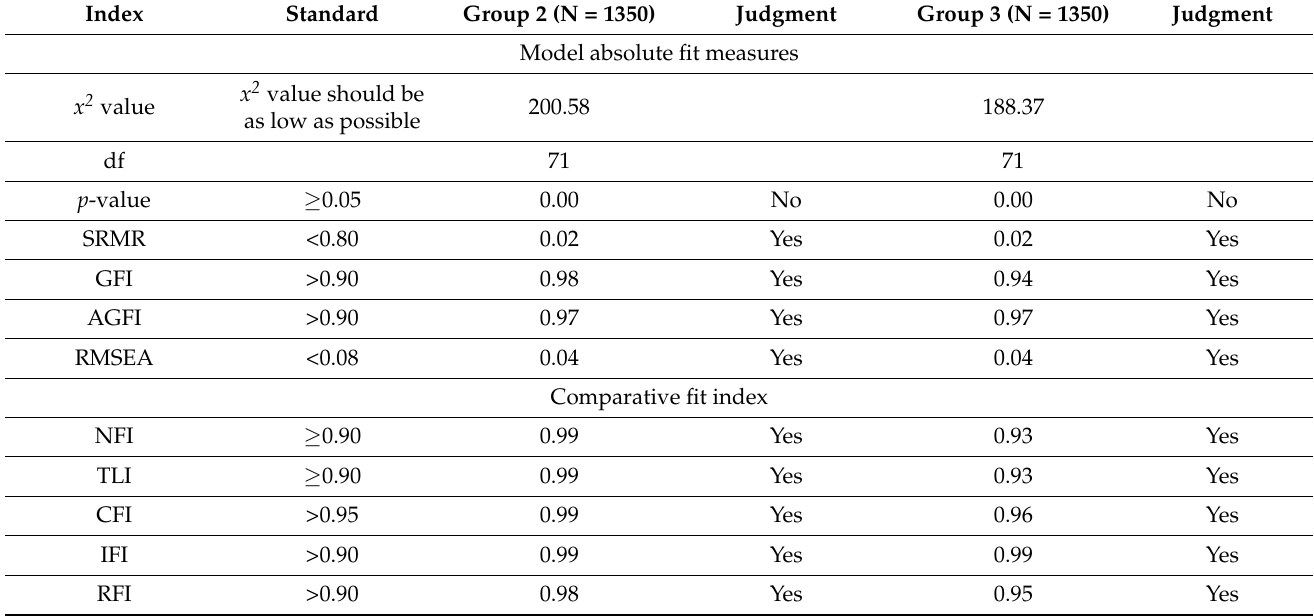
Table 8. Recreational Sport Well-being Model Goodness of Fit Indexes: Group 2 and Group 3 as